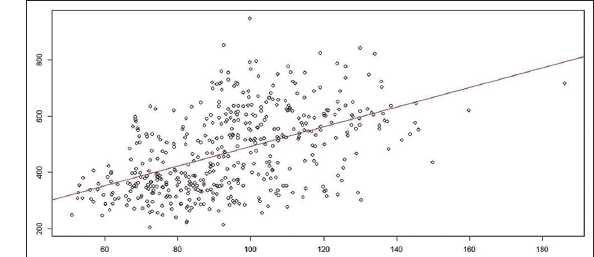
FIGURE 9. Regression line showing the tendency of the linear regression results of the maximum hand grip strength (Y-axis) unit is in Newton and the body weight unit is in kilograms of ages between 35 and 50 years (X-axis).